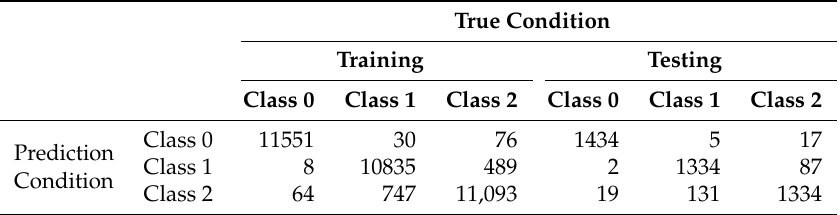
Table 8. DenseNet DBDDCA (3 class, 2 channel) confusion